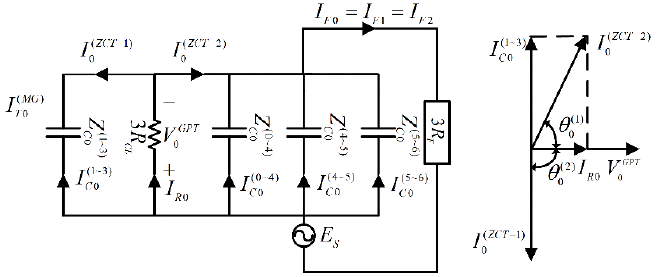
Figure 3. Simplified zero-sequence networks at the point of common coupling (PCC) bus for the microgrid SLG fault.